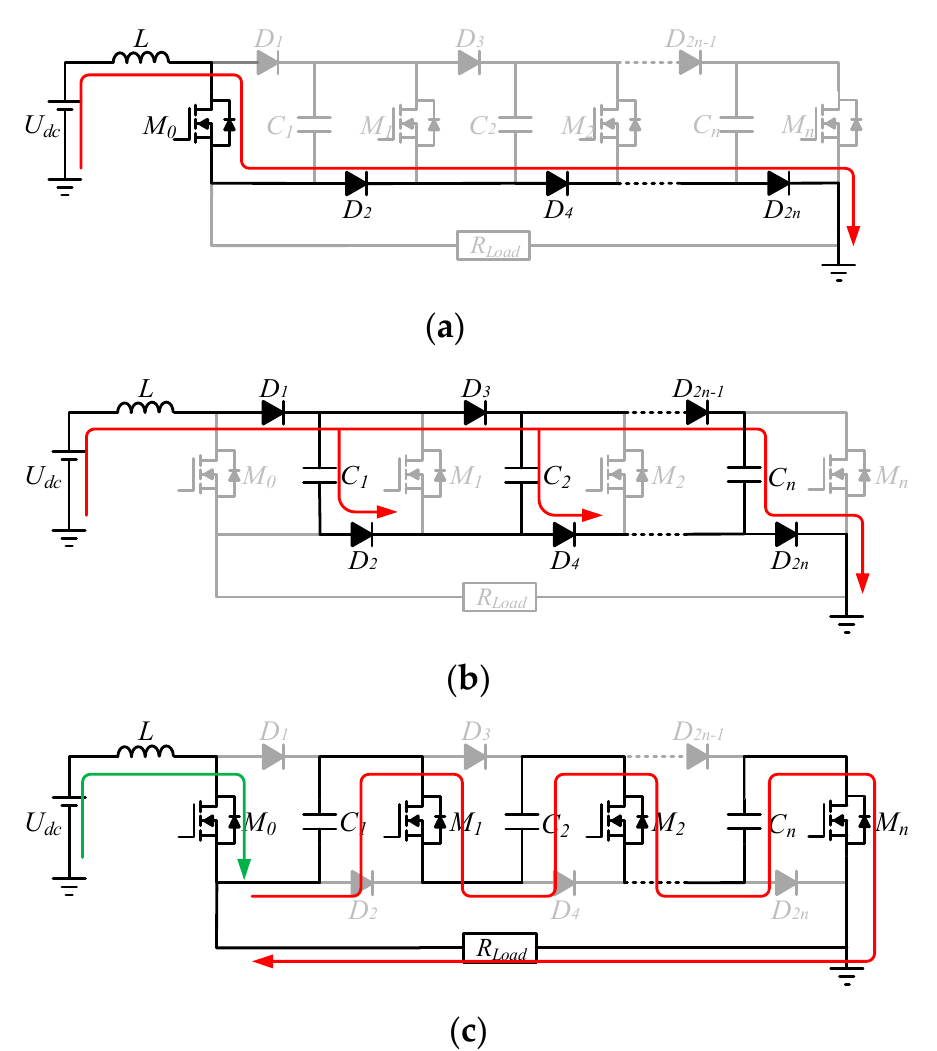
Figure 3. BMPG working mode schematic ( a ) Inductor energy storage mode, ( b ) Capacitor charge